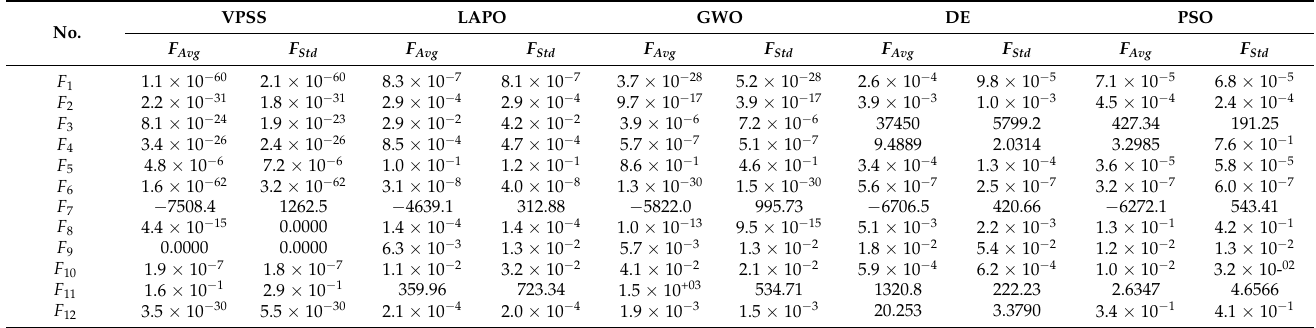
Table 2. Statistical results for the mathematical benchmark